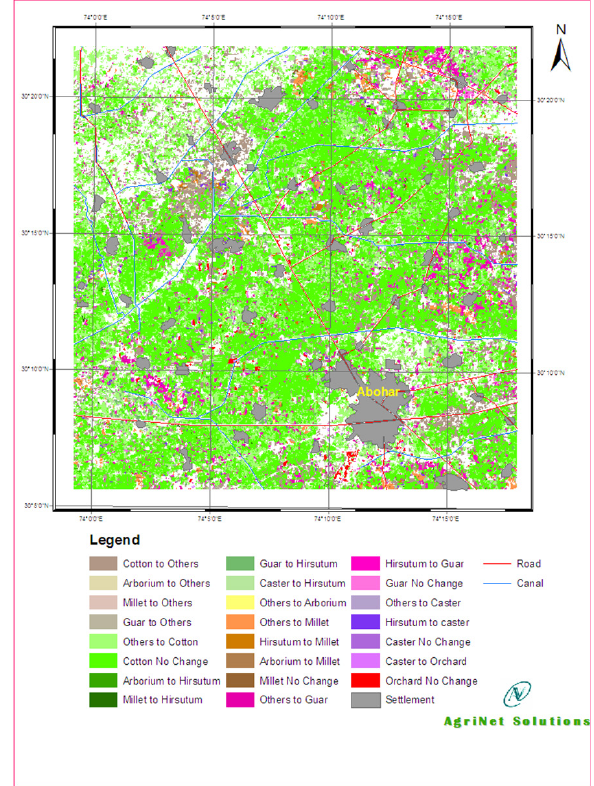
Figure-7. Change detection maps of parts of Ferozpur